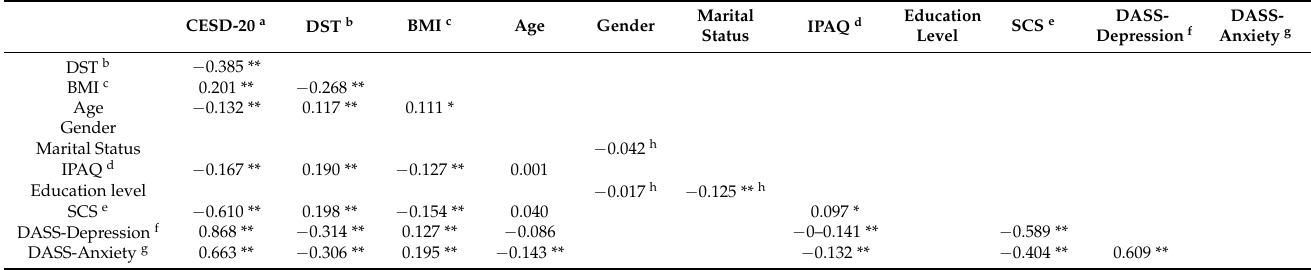
Table 2. Correlation matrix of overall population.